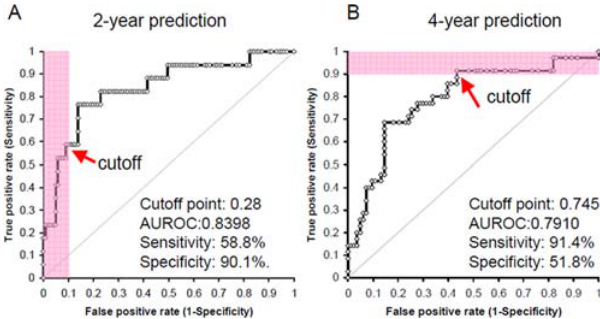
Figure 3. Best ROC curves of 2- and 4-year prediction models. A: For the 2-year prediction model, the best AUROC (0.8387) was obtained using 4 parameters: SL, pathology, p16, and methylation index (MI). Based on this ROC curve, we chose an output value cutoff point defining the HR group to maximize specificity ( . 90%, red area ) rather than sensitivity. B: For the 4-year model, the best AUROC (0.7910) was achieved using 3 parameters: SL, pathology, and MI. Based on this ROC curve, we selected an output value cutoff point defining the LR group to maximize sensitivity ( . 90%, red area ) rather than specificity.